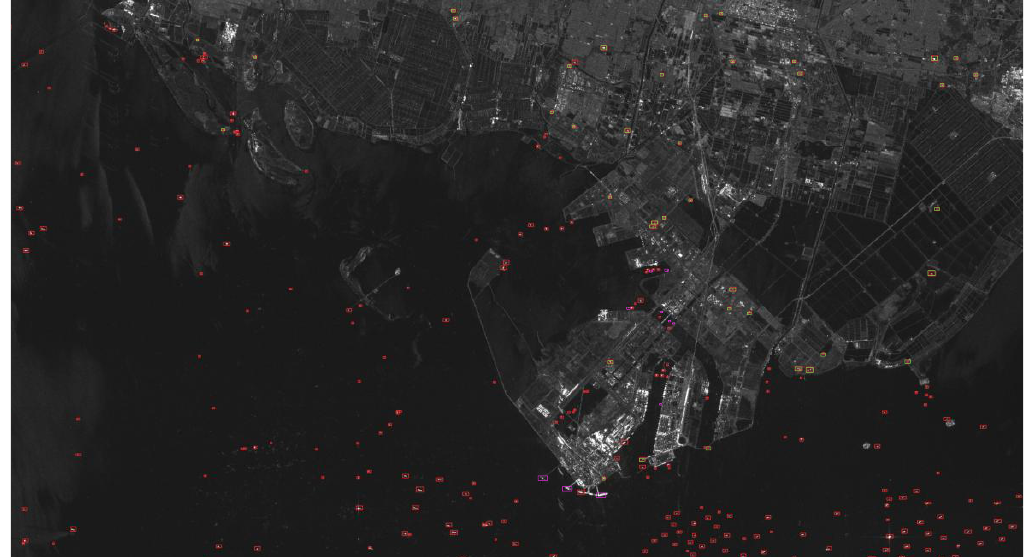
Figure 8. The detection results of the proposed method near the harbor area. The red, yellow and purple boxes represent the detected target, the false alarms and missing targets respectively.